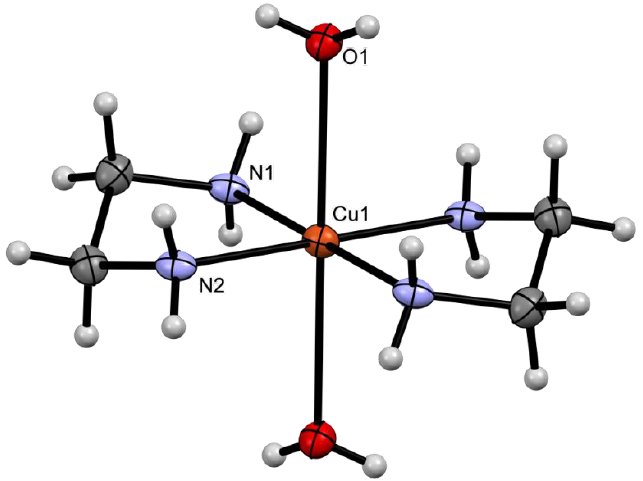
Figure 8. ORTEP drawing of [Cu(en) 2 (H 2 O) 2 ] 2+ , a complex cation of 5 . Displacement ellipsoids are drawn at the 50% probability level. Hydrogen atoms are shown as spheres of arbitrary radii.